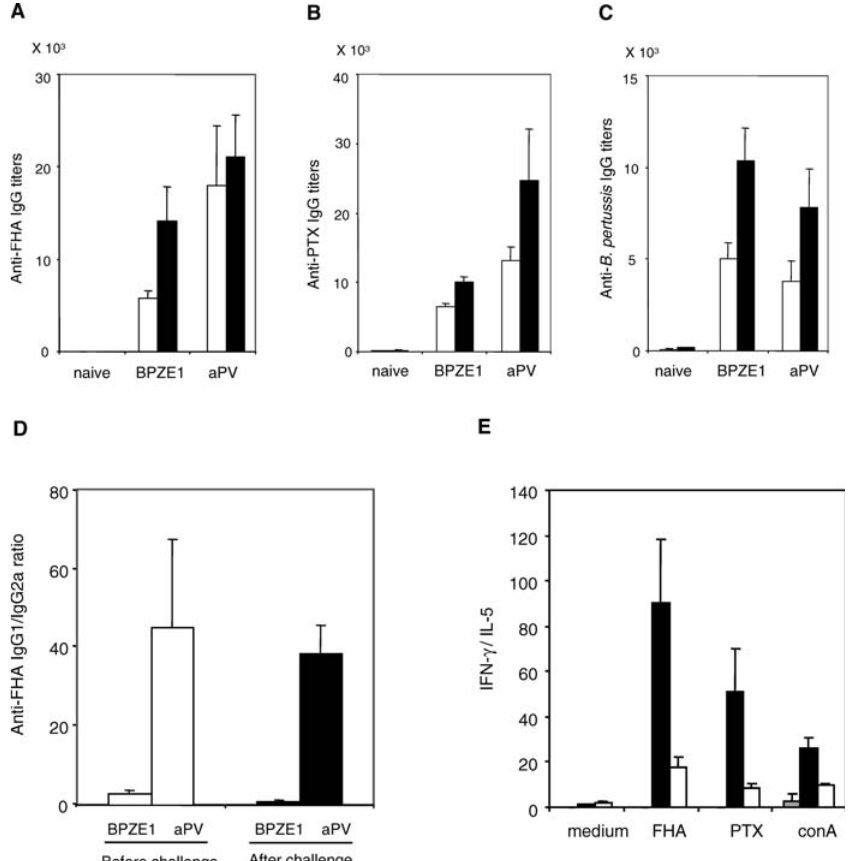
Figure 5. Immune Responses Induced in Infant Mice by BPZE1 or aPV Immunization (A) Anti-FHA, (B) anti-PTX, (C) anti- B. pertussis IgG heavy and light chain (H þ L) titers, and (D) anti-FHA IgG1/IgG2a ratios before (open columns) or 1 wk after BPSM challenge (filled columns) in BPZE1 or aPV immunized 3-wk-old mice, compared to controls. (E) IFN- c to IL-5 ratios produced by FHA-, PTX- or ConA-stimulated splenocytes from 8-wk-old mice vaccinated 2 mo before with BPZE1 (filled columns) or aPV (open columns), compared to controls (gray columns). Antibodies and cytokines were measured in individual mice, and the results are expressed as mean values ( 6 standard error) for four mice per group tested in triplicate. DOI: